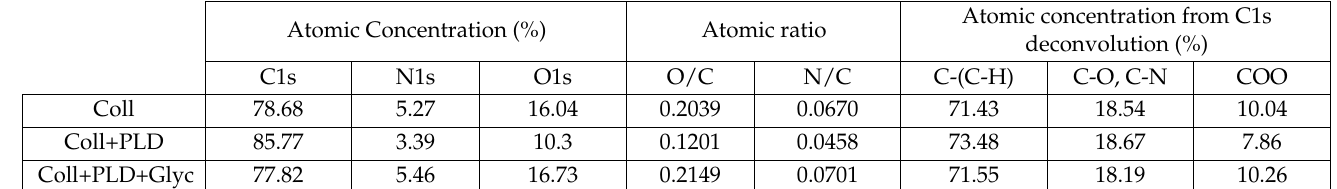
Table 2. Surface elemental composition and atomic ratios of Coll, Coll+PLD and Coll+PLD+Glyc vascular grafts obtained by XPS, and C1s